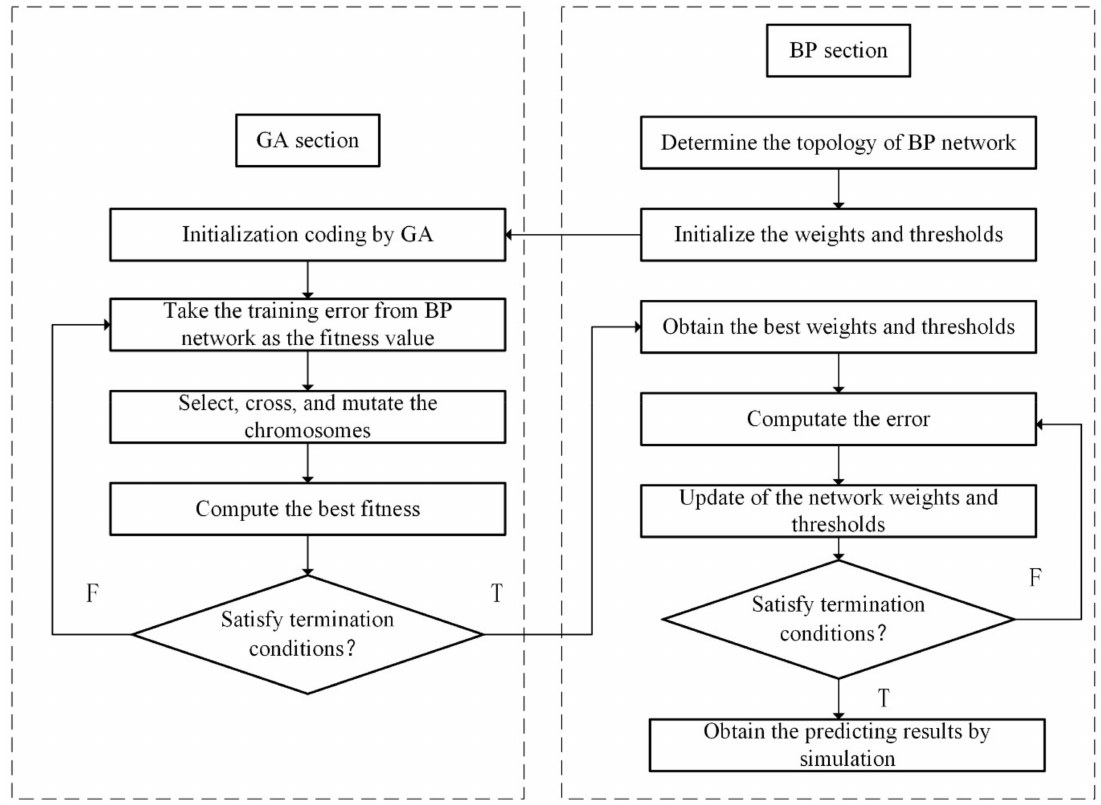
Figure 5. The flowchart of the GA-BP